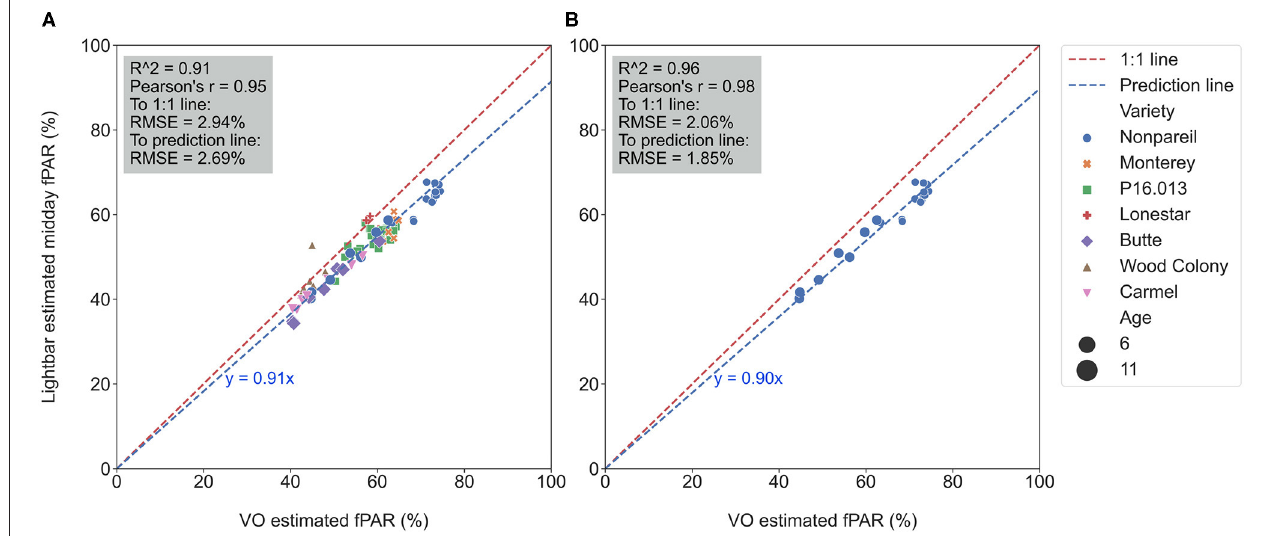
FIGURE 4 | Calibration of Virtual Orchard (VO) against mobile lightbar platform (both on June 26) estimated canopy fractional PAR (fPAR) with all varieties (A) and ‘Nonpareil’ only (B) at the per-row level (when forcing a zero